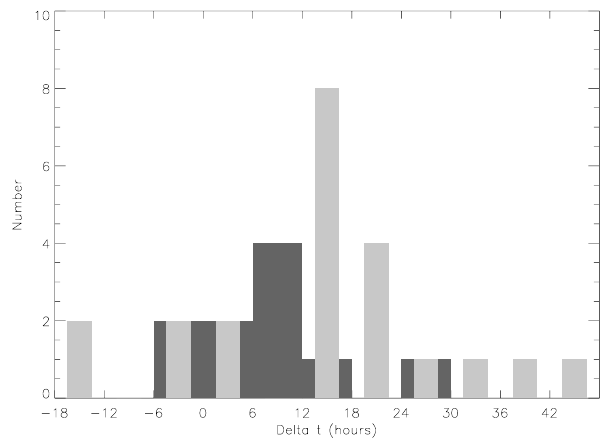
Fig. 9. In grey: Histogram of 1T (difference between onset time of chosen CME (column 7 of table 1) and t c (column 5)) for the cases associated with flares (Table 2). In black: same histogram for cases associated with filaments.